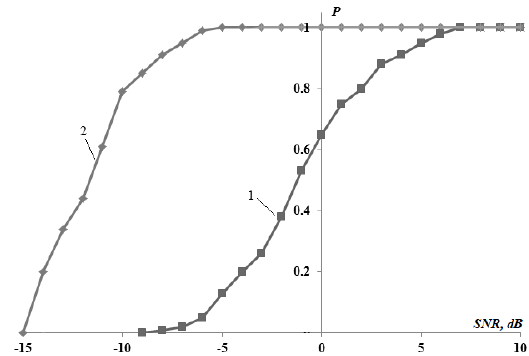
Fig. 2. The dependence of the correct time delay determining probability on the SNR: 1 – Mutual uncertainty function; 2 – Mutual uncertainty function with division into narrow-band channels (ISMS